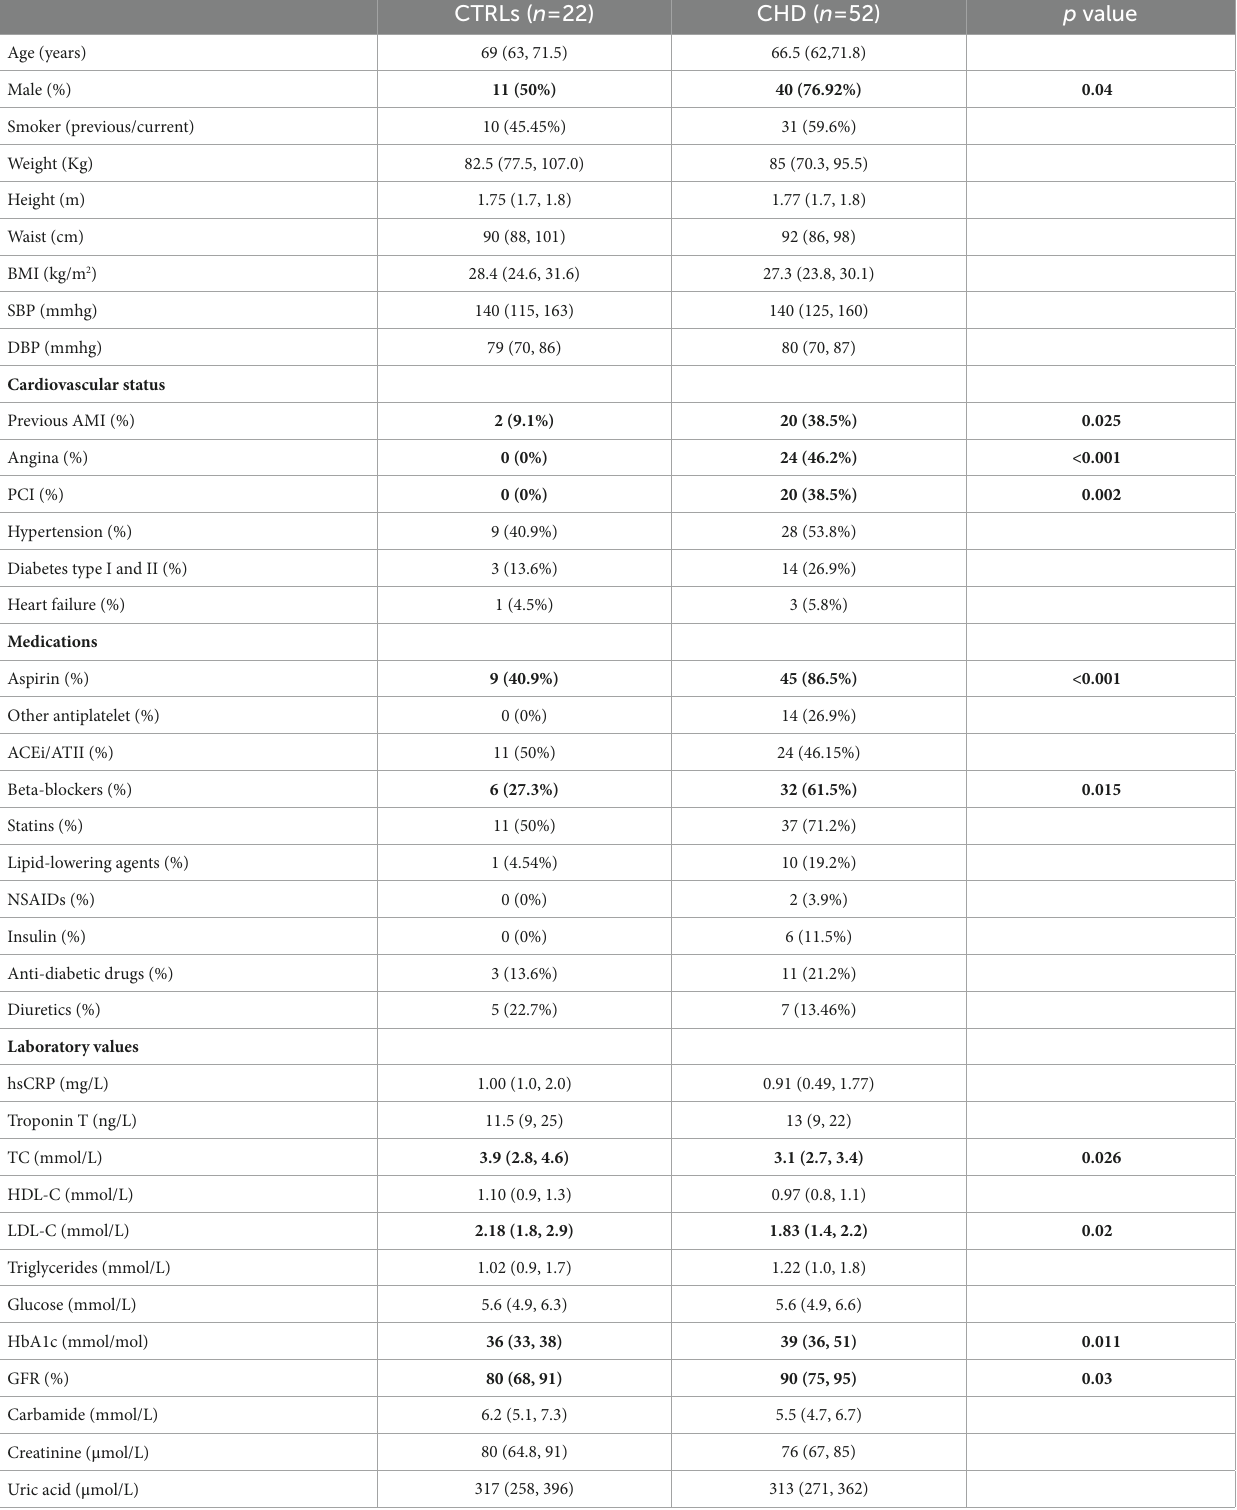
TABLE 1 Characteristics of the patient